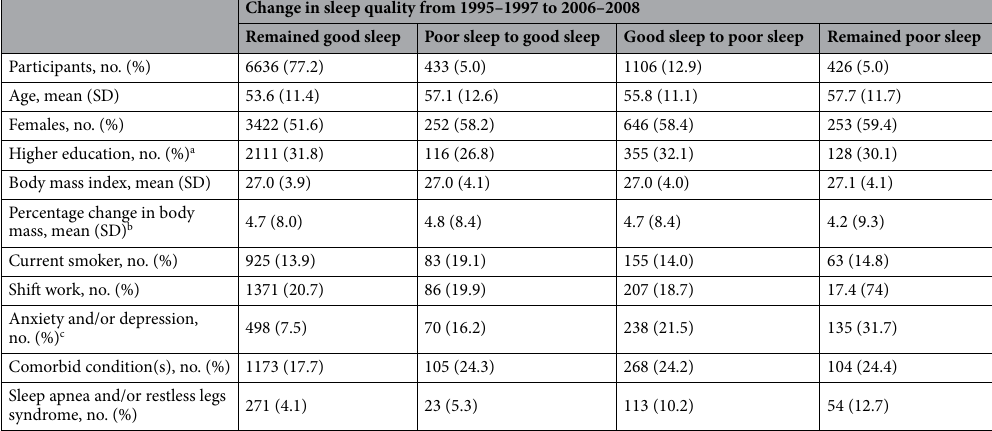
Table 1. Characteristics of the study population stratified by change in sleep quality from 1995–1997 to 2006–2008. SD standard deviation. a College or higher in 1995–1997. b Percentage change from 1995–1997 to 2006–2008. c Measured by Hospital Anxiety and Depression Scale score ≥ 8.